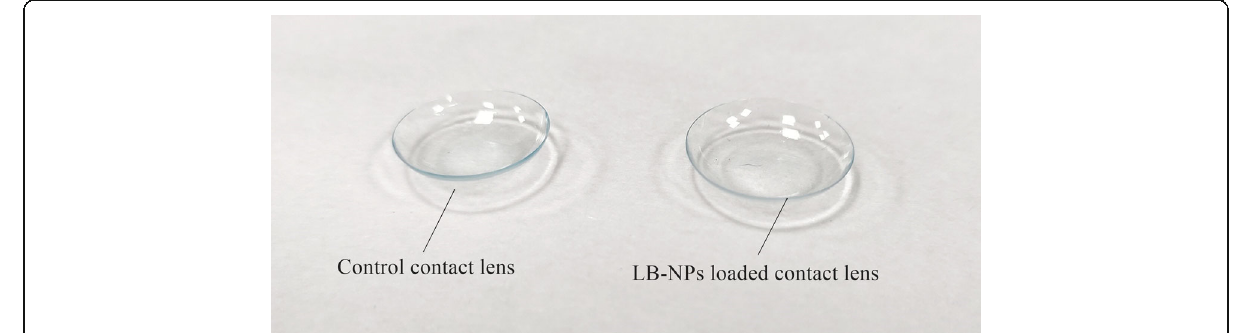
Fig. 9 Visual appearance of the control contact lens and LB-NP-loaded contact